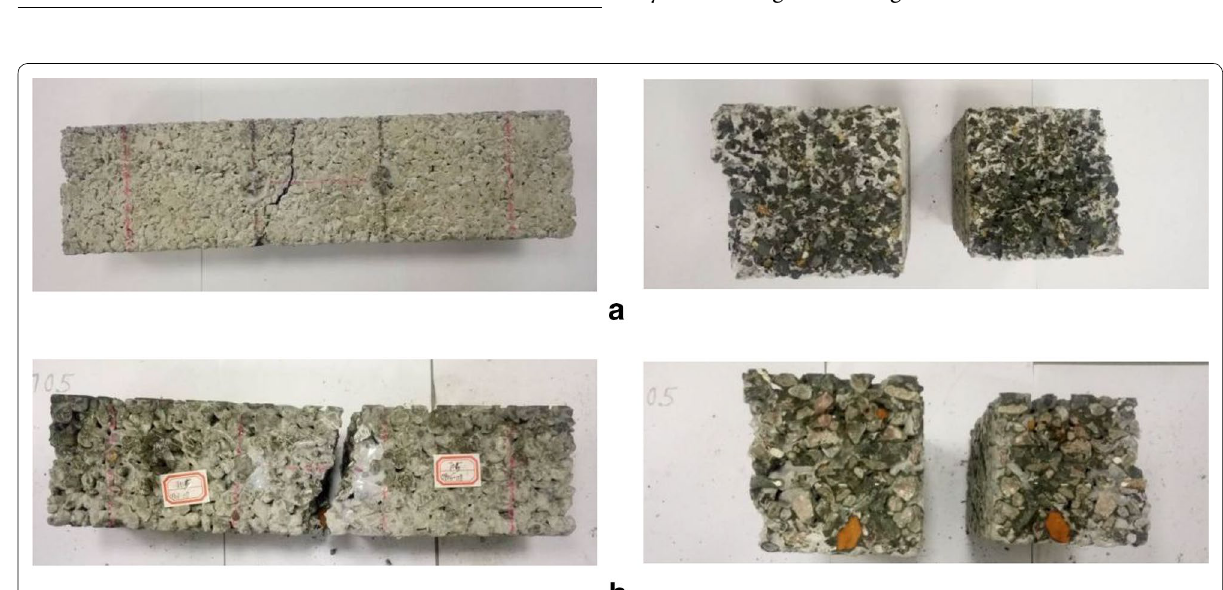
Fig. 4 Failure mode: a NAPC and b